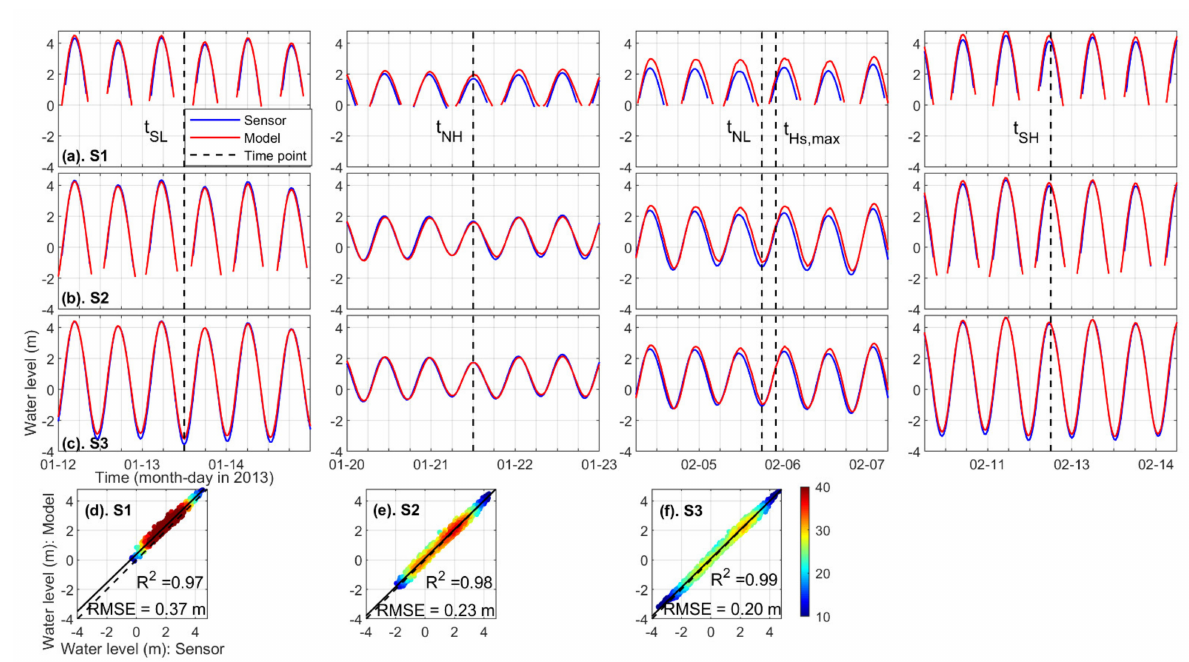
Figure 5. Comparison of the measured (blue) and the simulated (red) water levels at the pressure sensor locations: ( a ) S1, ( b ) S2, and ( c ) S3 (see Figure 4). For clarity, the comparisons were made around four time points (columns of a,b,c), t SL : 2013–01–13 12:00 (spring-low water), t NH : 2013–01–21 12:00 (neap-high), t NL : 2013–02–05 18:00 (neap-low), t SH : 2013–02–11: 18:00 (spring-high), where the time of occurrence of the peak storm wave height is also indicated t Hs,max : 2013–02–05 22:00 (just after t NL ). Scatter plots of measured and simulated water levels during the analysis period for ( d ) S1, ( e ) S2, and ( f ) S3, showing the calculated linear regression (solid line), perfect agreement (dashed line), and density of data points by percentage